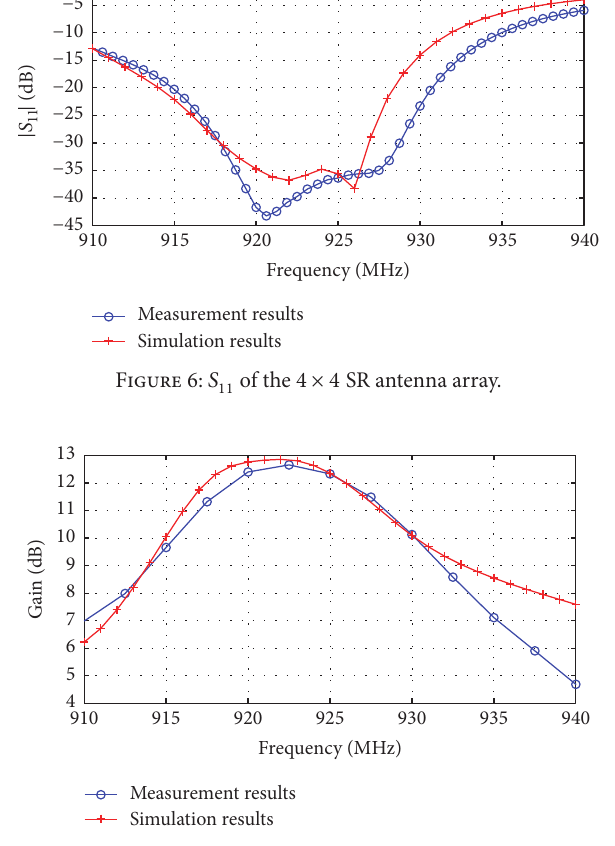
Figure 9: H plane AR as function of elevation angle at 922.5